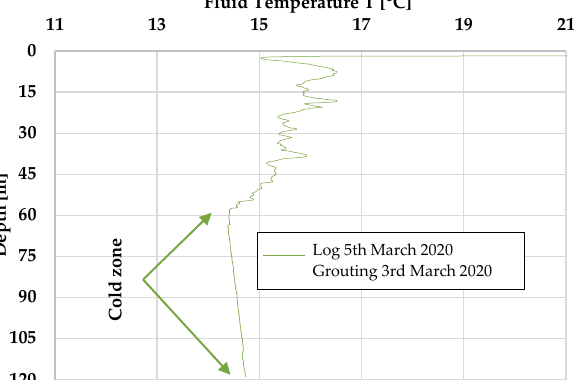
Figure 7. Vertical ground temperature profiles at the TAS-1 pilot BHE during the grout hydration period (5 February profile) as compared to the one at the end of the chemical reaction. A “cold zone” appears at the top BHE.